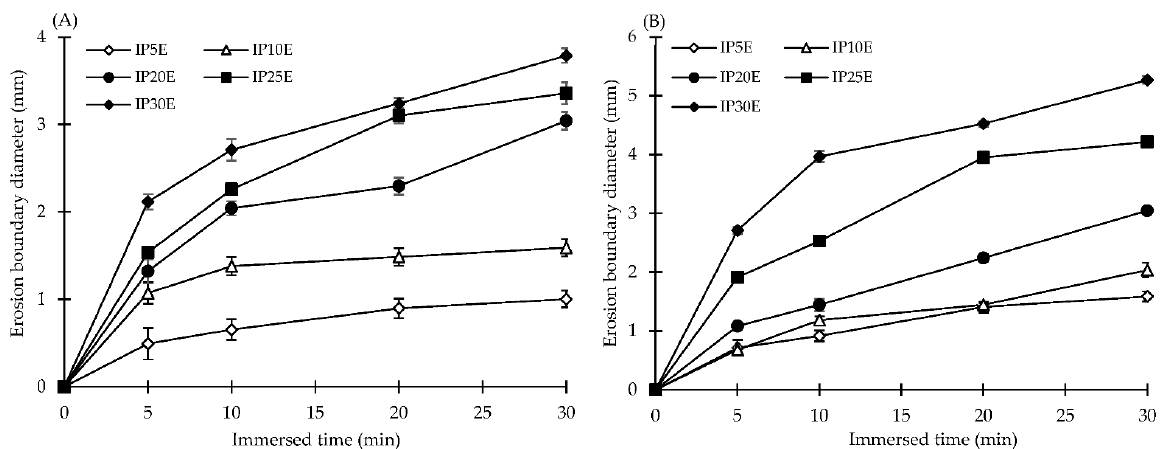
Figure 5. The erosion capacity of eutectic effervescent tablets in distilled water ( A ) and 0.1 N HCl buffer pH 1.2 ( B ).